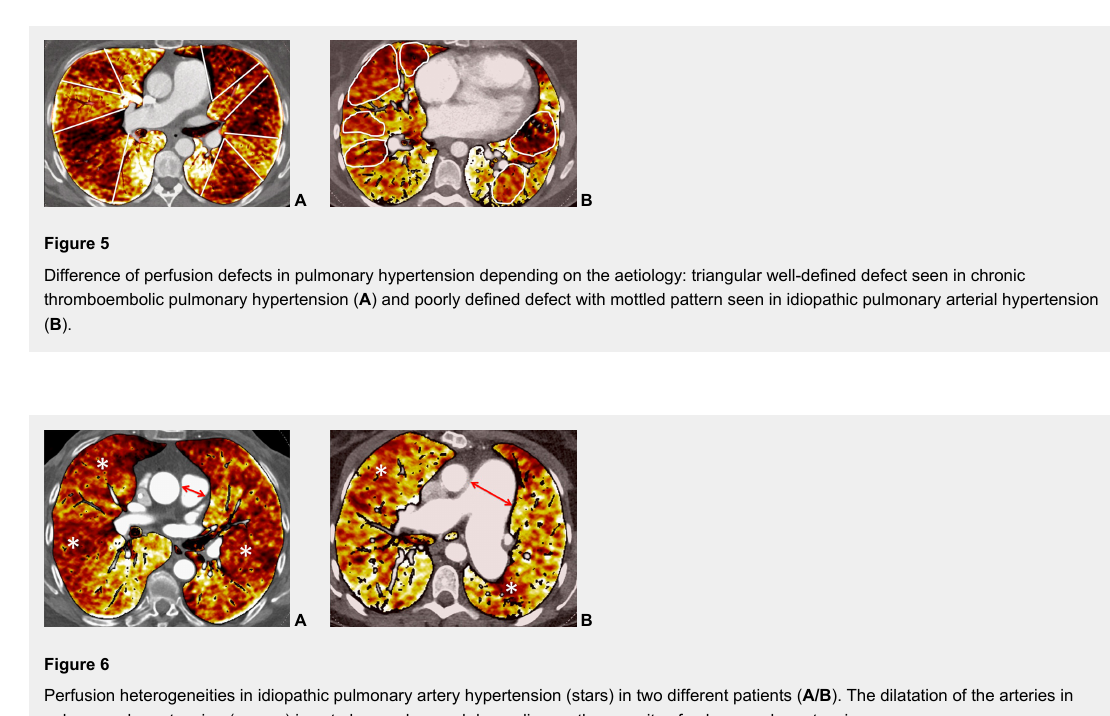
Perfusion heterogeneities in idiopathic pulmonary artery hypertension (stars) in two different patients ( A/B ). The dilatation of the arteries in pulmonary hypertension (arrows) is not always observed depending on the severity of pulmonary hypertension.